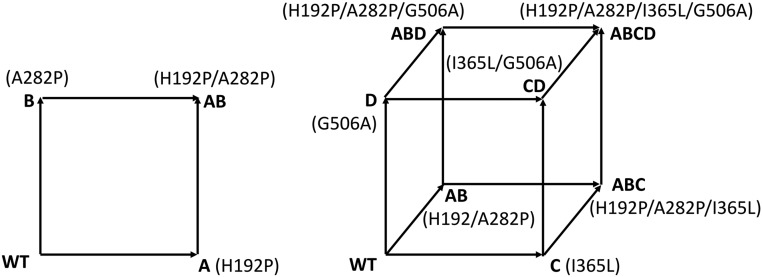
Graphical representation of sequence space from WT to the thermostable mutant H192P/A282P/I365L/G506A (ABCD), where each vertex of the cube represents a variant and each edge represents a single mutational step. Each variant was represented by letter(s): A—H192P, B—A282P, C—I365L, D—G506A, AB—H192P/A282P, CD—I365L/G506A, ABC—H192P/A282P/I365L, ABD—H192P/A282P/G506A, and ABCD—H192P/A282P/I365L/G506A.